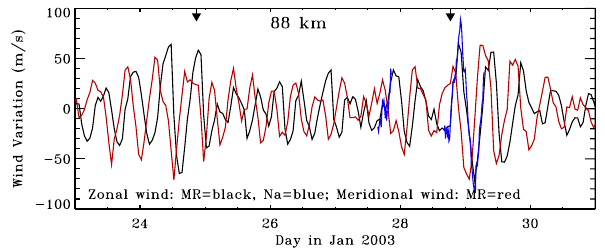
Fig. 17. ARR measurements of changes in the zonal wind at 88km measured by the Na lidar (blue) and the meteor radar (MR, black), and of the meridional wind by MR (red) from 25–31 January 2003. The figure shows the strong amplification of the planetary wave on 28 January. Launch time of each winter MaCWAVE rocket is rep- resented by the arrows at the top of the figure.